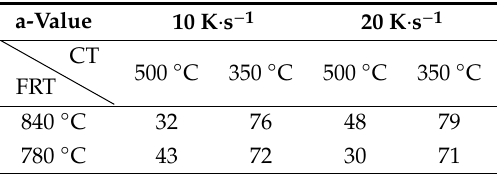
Figure 13. Stress–strain curves, after strain aging, of samples with the prescribed TMP parameters; ( a ) FRT = 840 ◦ C, ( b ) FRT 780 ◦ C, ( c ) a = 10 K · s − 1 and ( d ) a = 20 K · s − 1 . Table 3. Strain aging potential